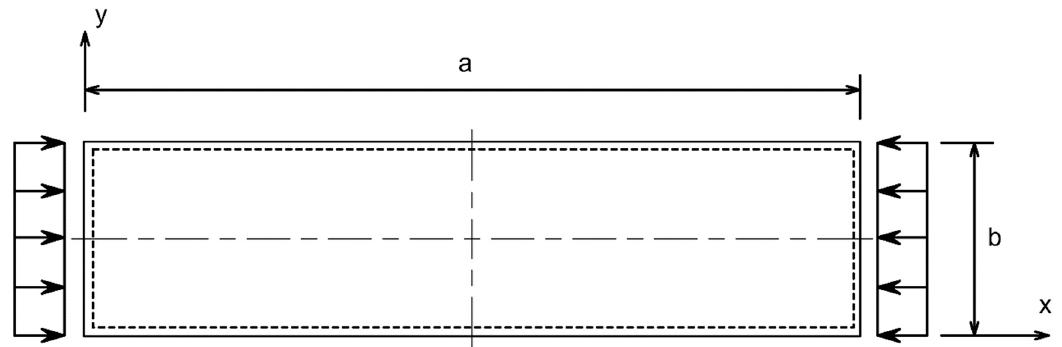
Figure 1. Simply supported thin rectangular plate subjected to an in-plane uniaxial load [1].